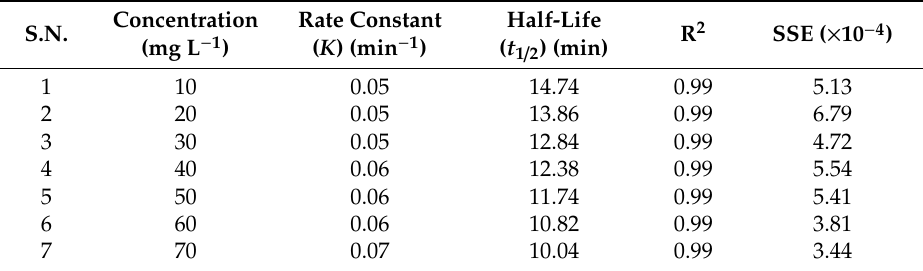
Table 4. Pseudo-first-order kinetic model for the photodegradation of DNP by PAN-g-Alg@Ag NC with the associated error